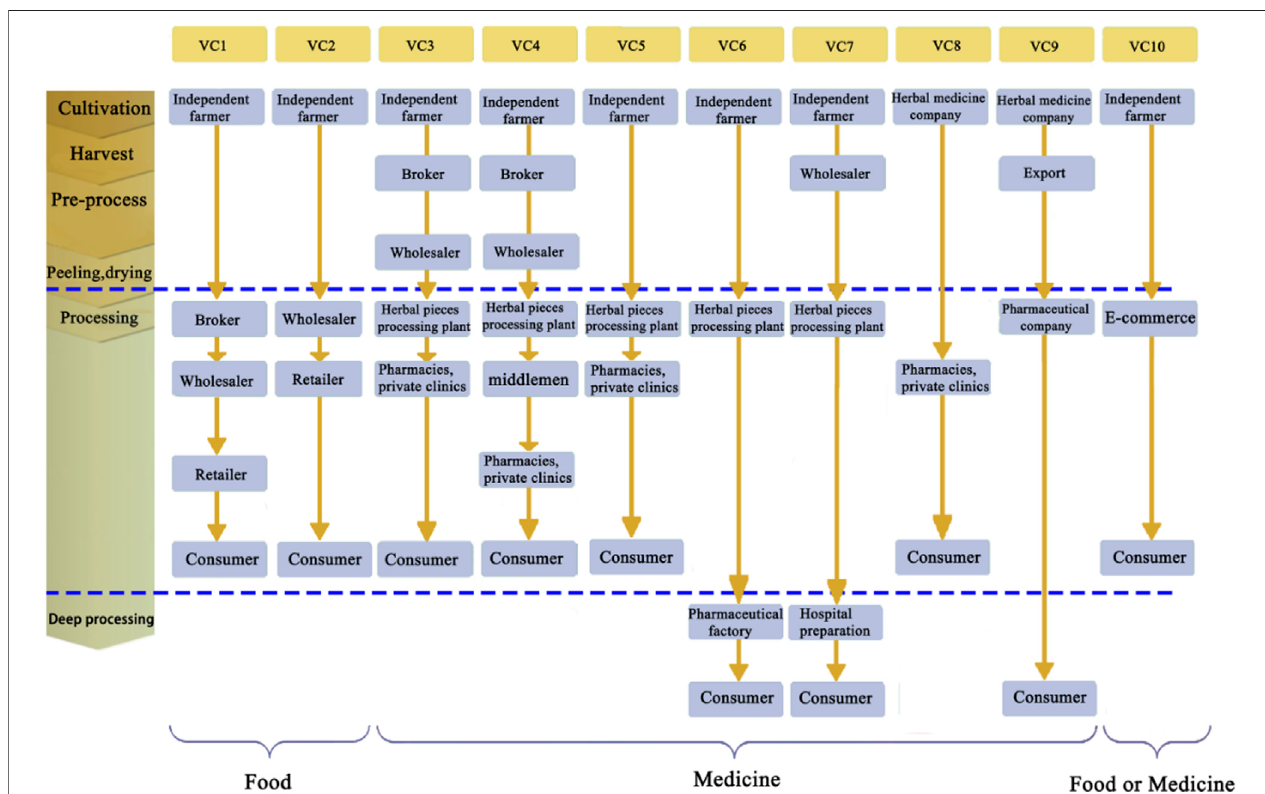
FIGURE 3 | The 10 value chains of GR were drawn after